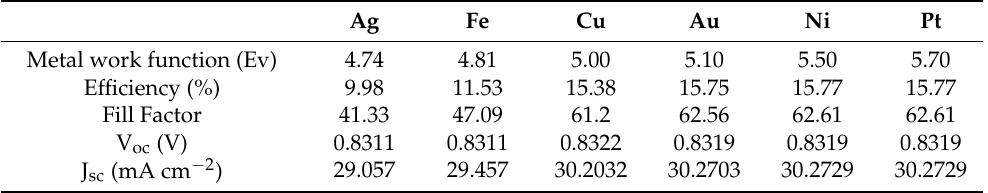
Table 4. Influence of different back contact on the device